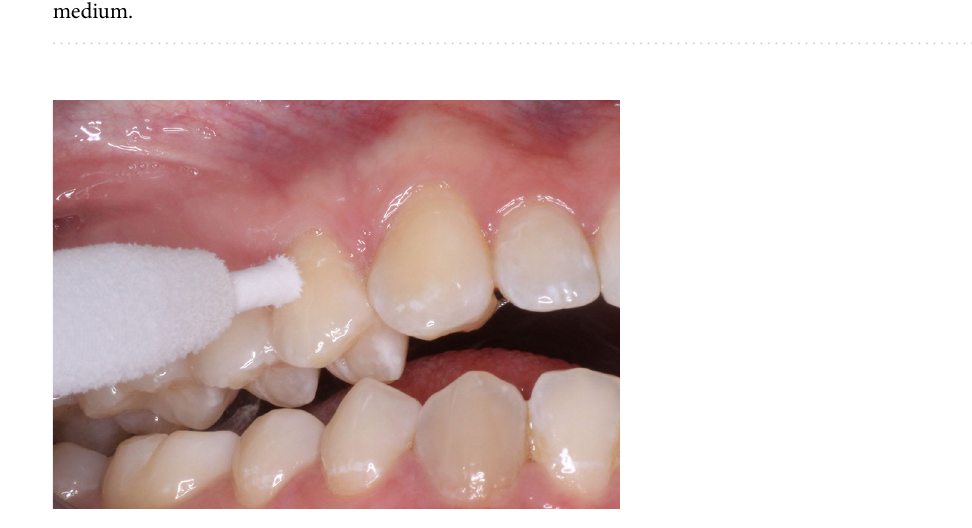
Figure 4. Application of a CO 2 snow stick onto the buccal surface of the test